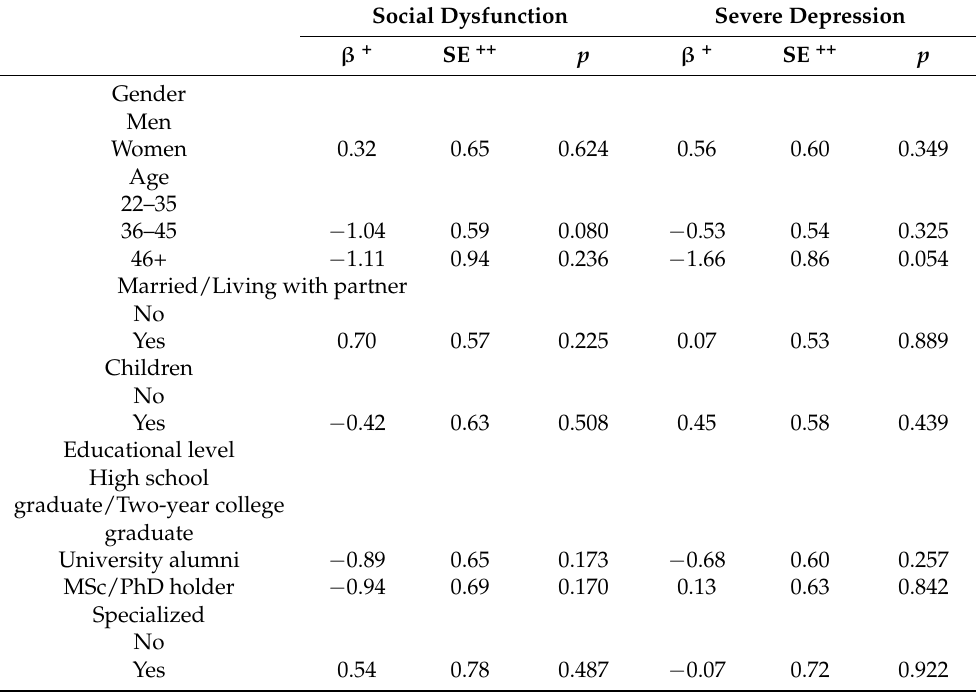
Table 4. Multiple linear regression results with social dysfunction and severe depression subscales as dependent